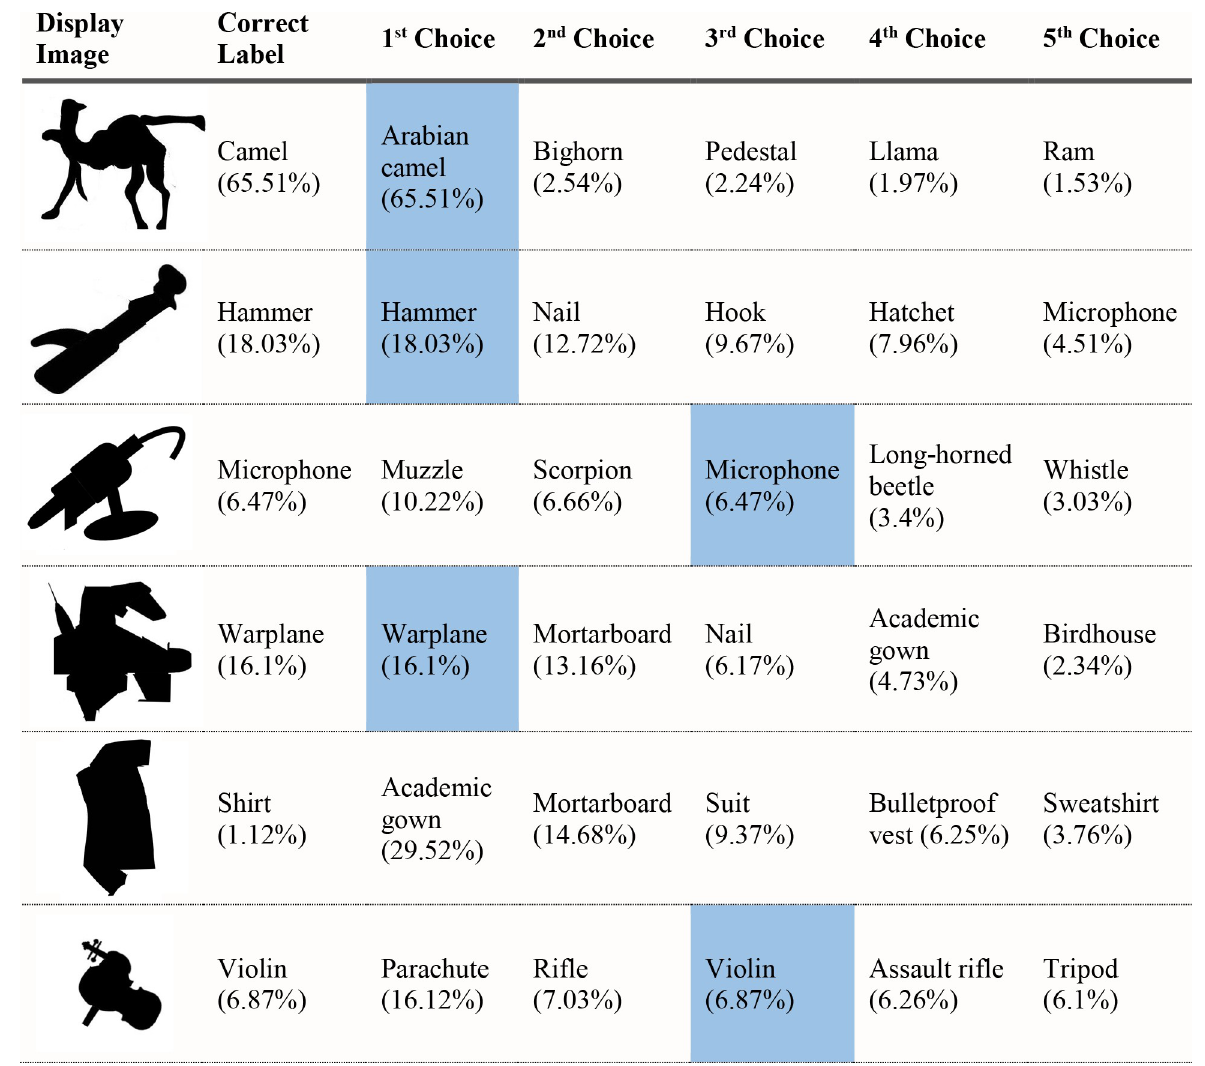
Fig 24. VGG-19 classifications for part-scrambled silhouettes. The leftmost column shows the image presented to the DCNN. The second column shows the correct object label and the classification probability produced by the network for that label. The other five columns show probabilities for the network’s top five classifications, ordered left to right from highest to lowest. Correct classifications are shaded in blue.